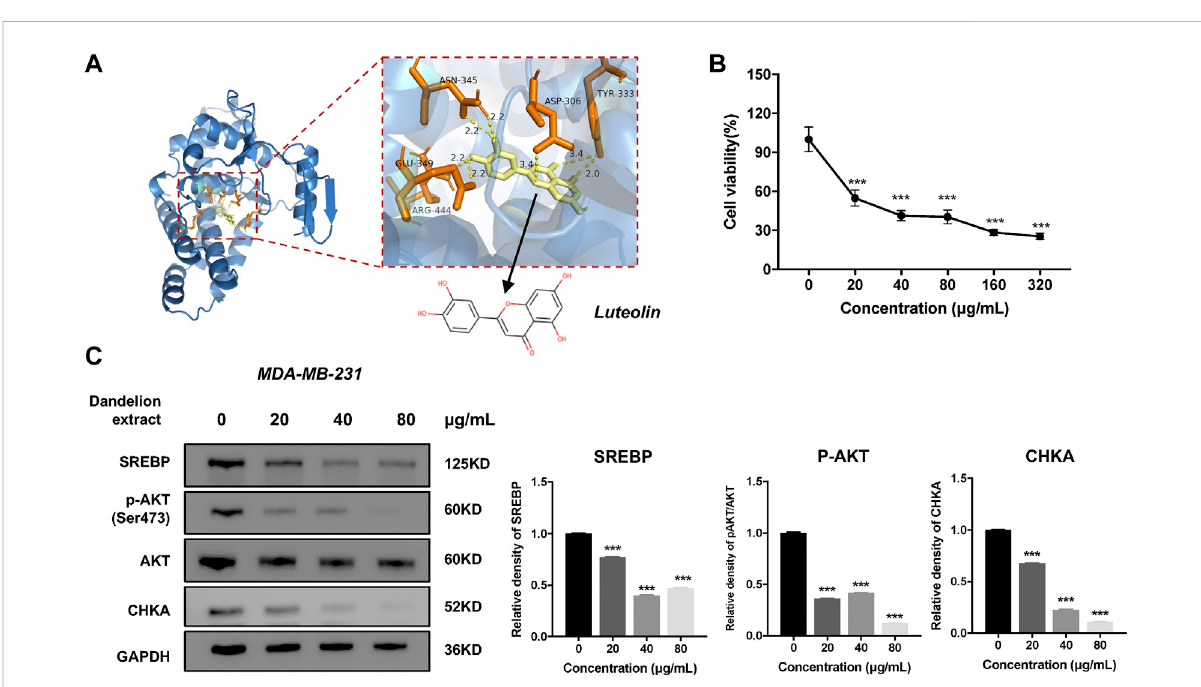
FIGURE 9 The luteolincouldinhibit TNBCcell proliferationand reduce theexpression level of CHKA. (A) The interactions ofthepotential crystal structure ofCHKAdomainincomplexwithluteolinbasedonthemoleculardockingsimulation.Thedottedlinebetweenthecompoundandtheproteinrefers to the hydrogen bond. TYR, tyrosine; CLU, glutamic acid; SER, serine; LEU, leucine; ASN, Asparagine; ASP, Aspartic acid; ARG, Arginine. (B) . Luteolin inhibitedMDA-MB-231cellproliferationbyMTTassays. (C) .LuteolinreducedtheexpressionlevelsofSREBP,CHKA,andp-AKT. *p < 0.05,**p < 0.01, ***p < 0.00 1 vs. 0 μ